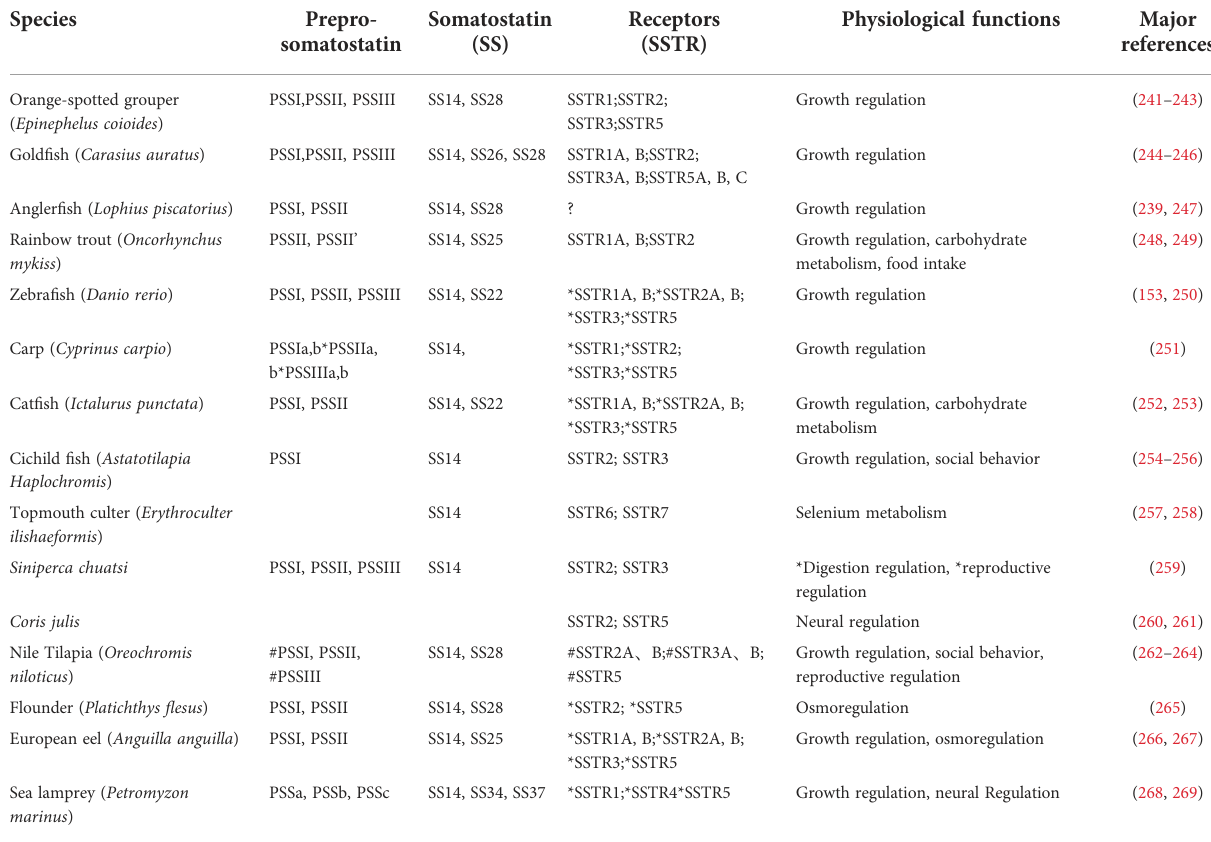
TABLE 4 Somatostatin and its receptors have been identi fi ed in fi